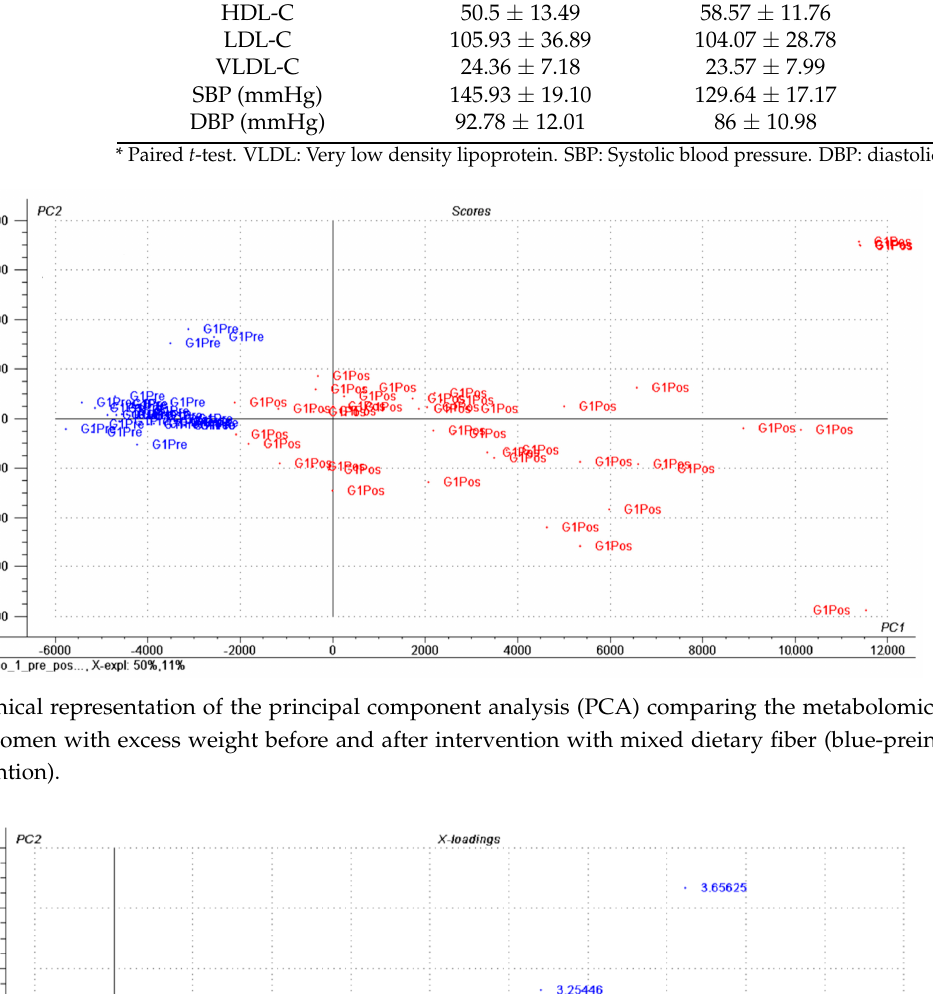
Table 2. Comparison of the blood pressures and lipid profiles of hypertensive women with excess weight, recruited from the Blood Donor Centre of João Pessoa, PB, Brazil, before and after inter- vention with mixed dietary fiber.